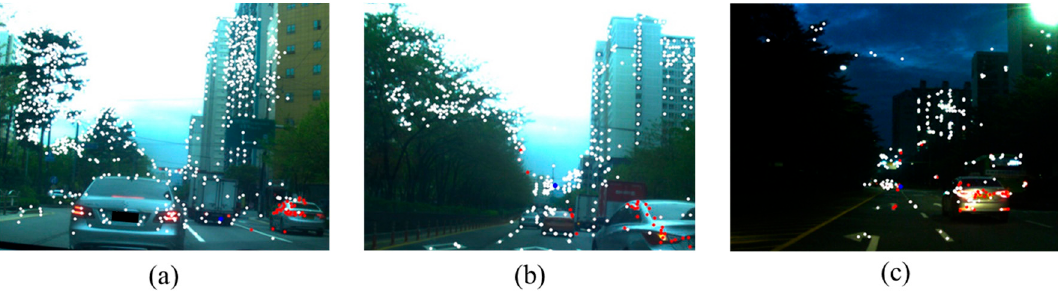
Figure 6. Feature point classification with example images. ( a ) Example image 1; ( b ) example image 2; ( c ) example image